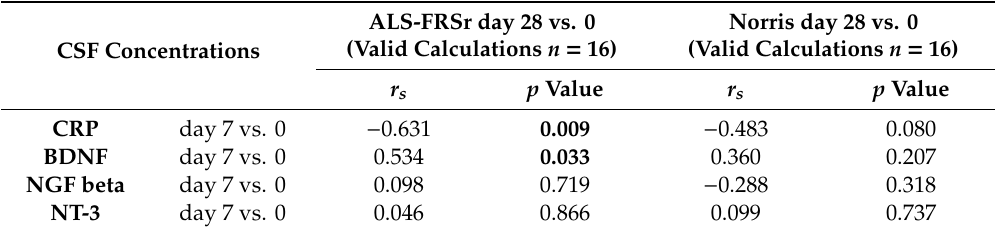
Table 2. Correlations analysis between CSF concentration of selected factors and clinical outcome measured using ALS-FRSr and Norris scale. rs: Spearman’s correlation coefficient. p < 0.05 is highlighted with bold font.